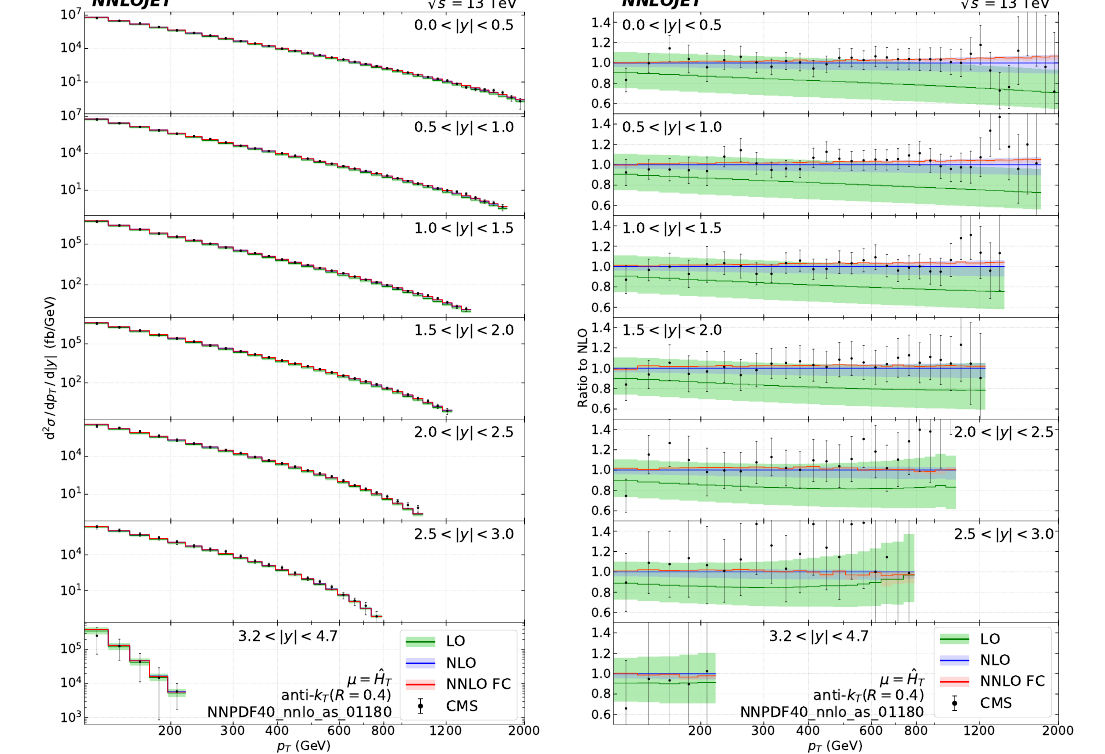
Figure 2 . Double differential single jet inclusive cross sections as function of the jet p T for all rapidity slices with R = 0 . 4 anti- k T jets (left), and normalized to the NLO result (right). Predictions are compared to CMS data